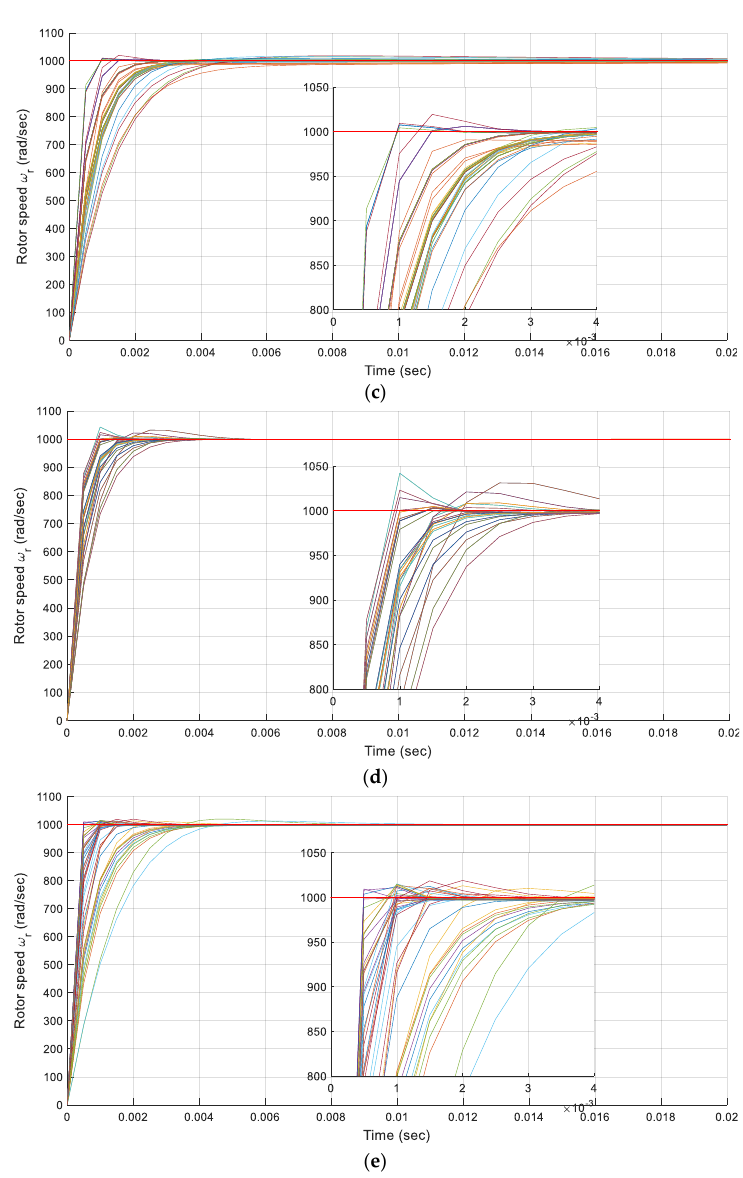
Figure 7. Motor response to step and constant torque ( a ) Response using BA; ( b ) Response using BBO; ( c ) Response using CSA; ( d ) Response using FPA; ( e ) Response using SCA.